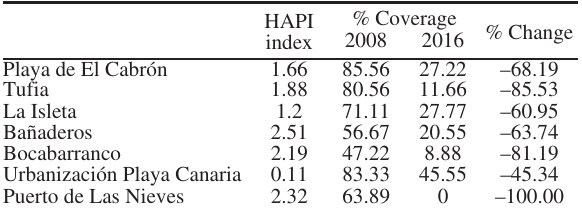
Table 3. – Values of the HAPI index, coverage and rate of tempo- ral change for each of the seven studied Cystoseira abies-marina